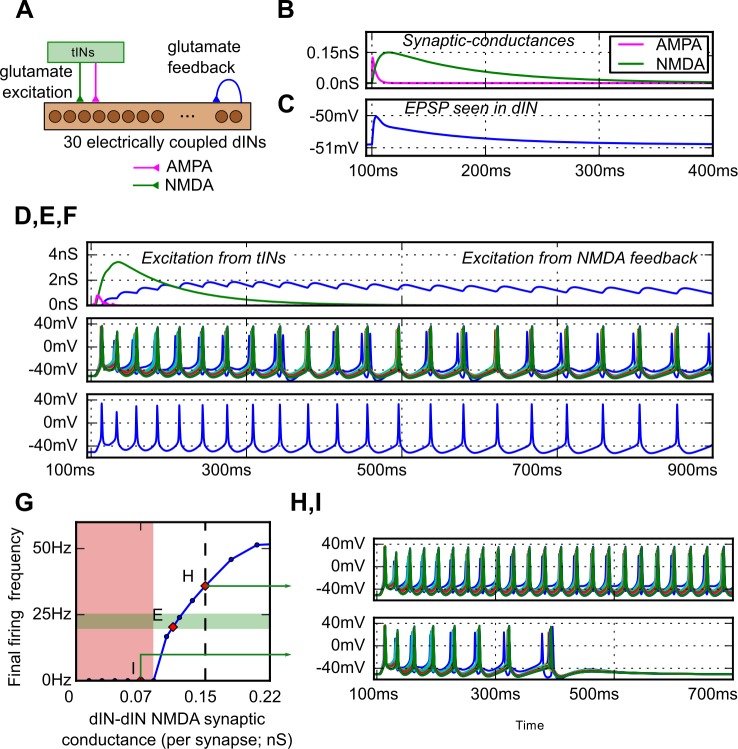
The response of a dIN network with feedback glutamate excitation to brief sensory excitation.(A) The network of 30 electrically-coupled dINs excited by sensory pathway tINs and with feedback glutamatergic synapses. (B) The conductance time-courses of the feedback dIN excitation with faster AMPAR (magenta) and slower NMDAR (green) components. (C) The resulting combined dIN to dIN EPSP. (D—F) Response to sensory input from tINs at 100 ms. (D) The conductance of sensory synapses onto one dIN (magenta: AMPAR, green: NMDAR) and summed NMDAR conductance from dIN feedback (blue). (E) After firing once to sensory input from the tINs, the dIN network shows rhythmic activity within the tadpole frequency range driven by feedback NMDAR excitation (0.11nS/synapse). (F) A single dIN voltage trace from E. (G) The effect of dIN to dIN NMDA feedback conductance on dIN firing frequency (conductance values are for a single dIN to dIN synapse). Rhythmic firing at physiologically observed frequencies is observed (green area). At low levels of synaptic strength, swimming is not reliable (red area, I). (H) At higher levels of feedback synaptic strength (0.15 nS/synapse) firing is outside normal tadpole range. (I) At lower feedback strengths (0.07nS/synapse) rhythmic firing cannot self-sustain and activity ceases after a few cycles.